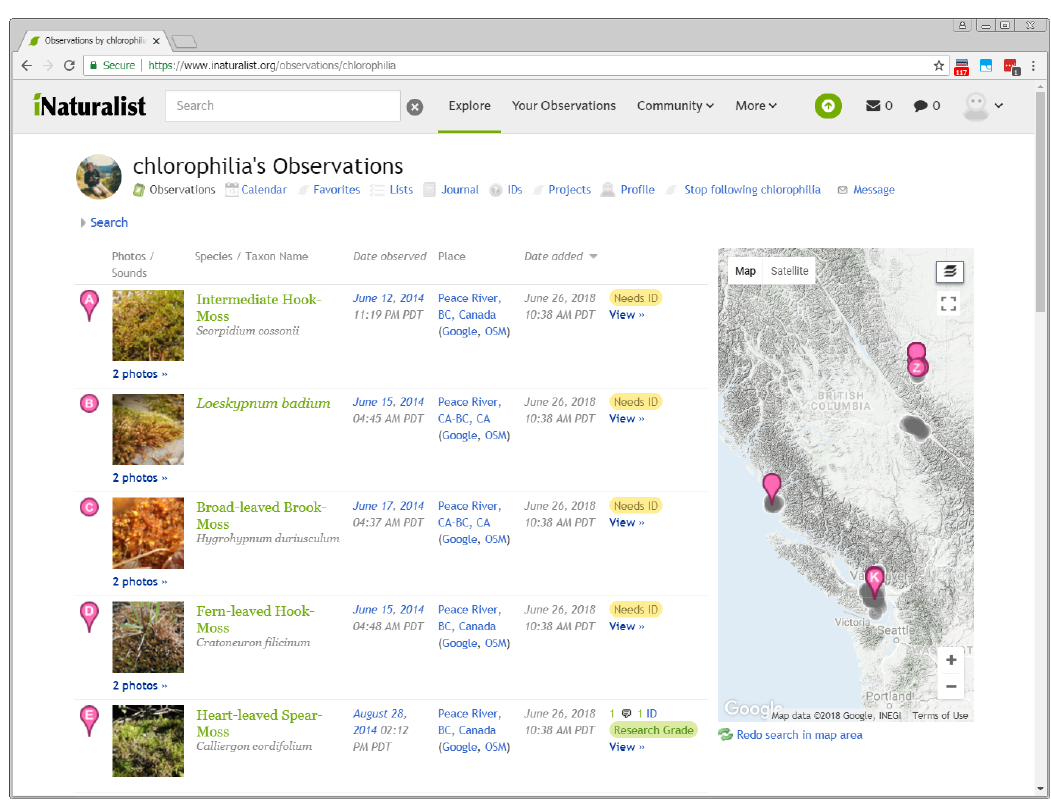
Figure 3 – A view of one contributor’s observations on